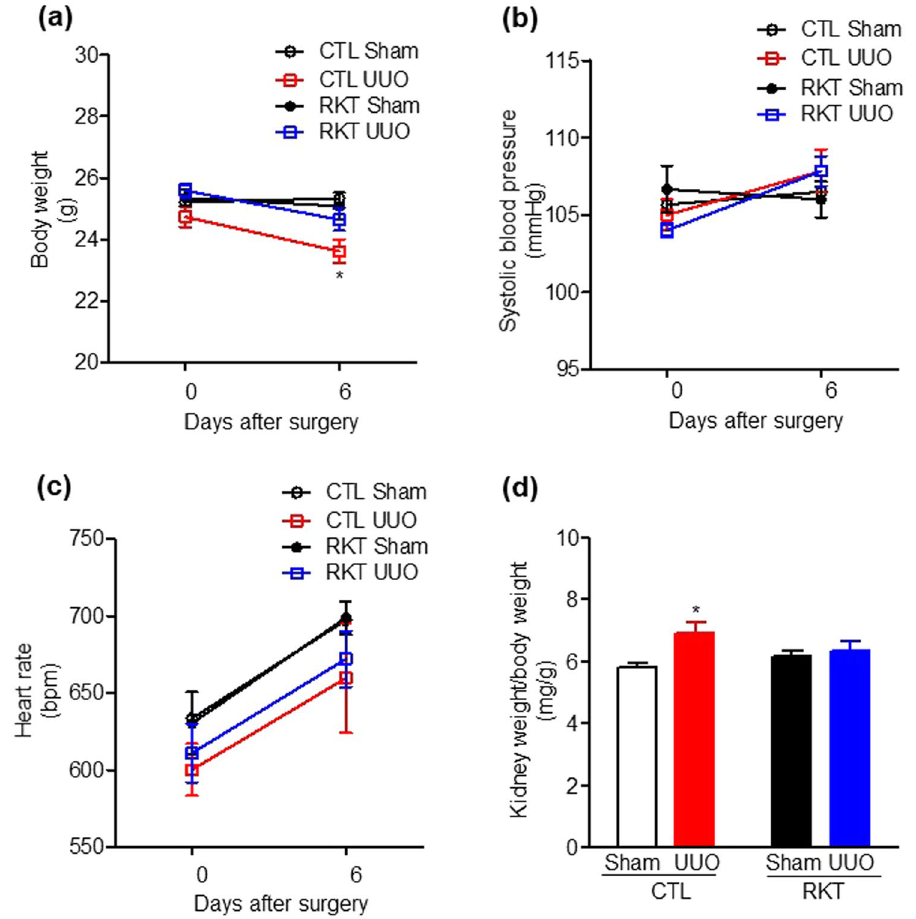
Figure 1. Effects of Rikkunshito treatment on body weight gain, blood pressure, heart rate, and the kidney weight/body weight ratio in sham- and UUO-operated mice. Effects of Rikkunshito treatment on body weight ( a ), systolic blood pressure ( b ), heart rate ( c ), and kidney weight/body weight ratio. ( d ) Values are expressed as the mean ± SE (n = 6 per group). Differences in body weight among the four groups over time were analysed by two-way repeated measures ANOVA with Bonferroni’s post-test. * P < 0.05 vs sham-operated group. CTL, control standard diet; RKT, diet containing Rikkunshito; UUO, unilateral ureteral